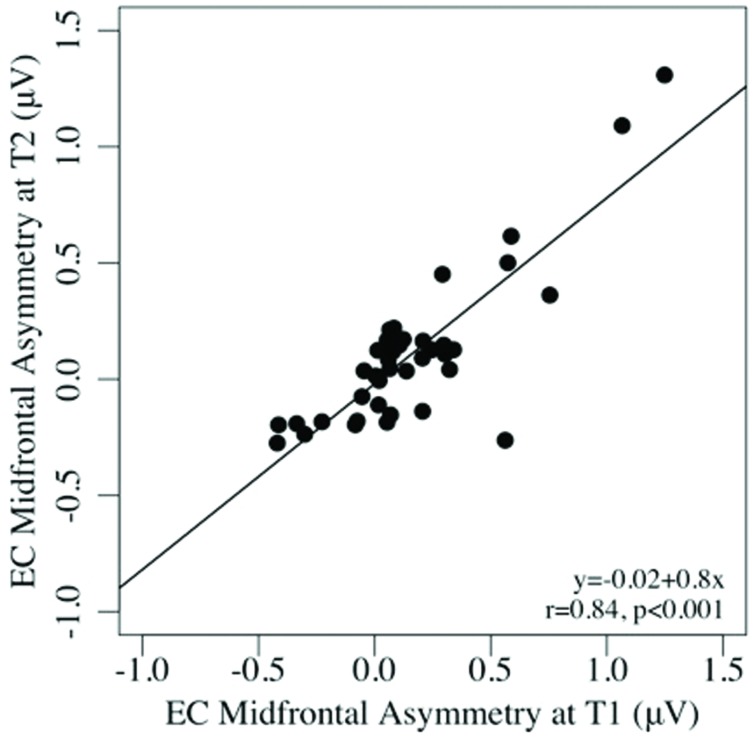
Scatterplots of the associations between mid-frontal asymmetry in the eyes-closed, pre-task (T1), and post-task (T2) conditions.